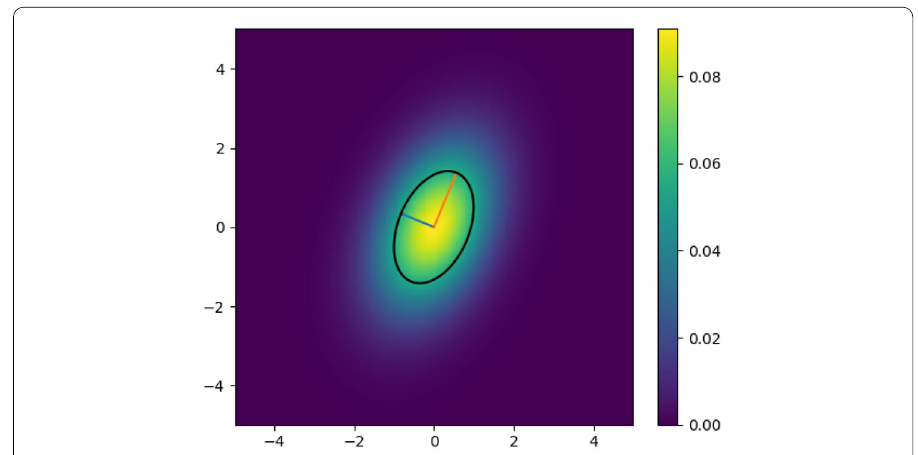
Fig. 3 Bivariate normal distribution associated with variances 1. and 2. and covariance 0.5. Eigenvalues are = 0 . 79 and (cid:6) = 2 . 21, associated to eigenvectors [ − 0 . 92 , 0 . 38] and [0 . 38 , 0 . 92]. In black, the ellipse with (cid:6) √ √ 1 2 (cid:6) (cid:6) semi-axes of lenghts 1 and